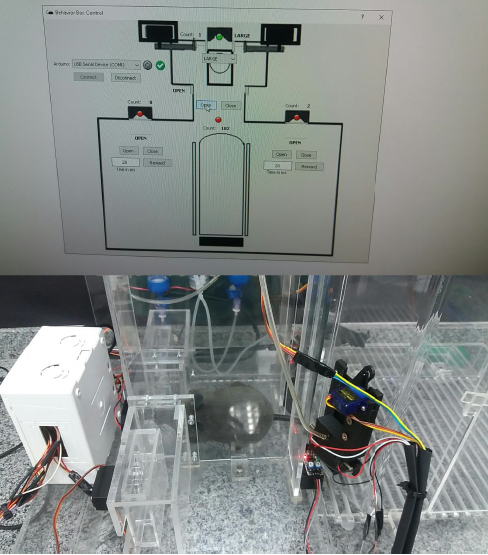
Figure 24. Remote control mouse in behavior box: activating the central nose poke sensor, referring to the discrimination step, with the mouse vibrissae touching the